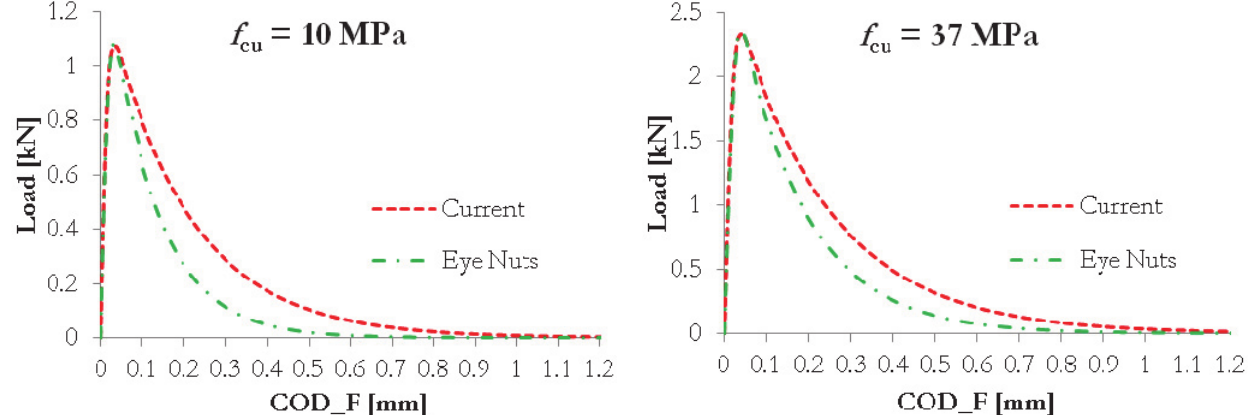
Figure 5: The final Load-COD_F diagrams for f cu 10 and 37 MPa used for the calculation of fracture energy values.